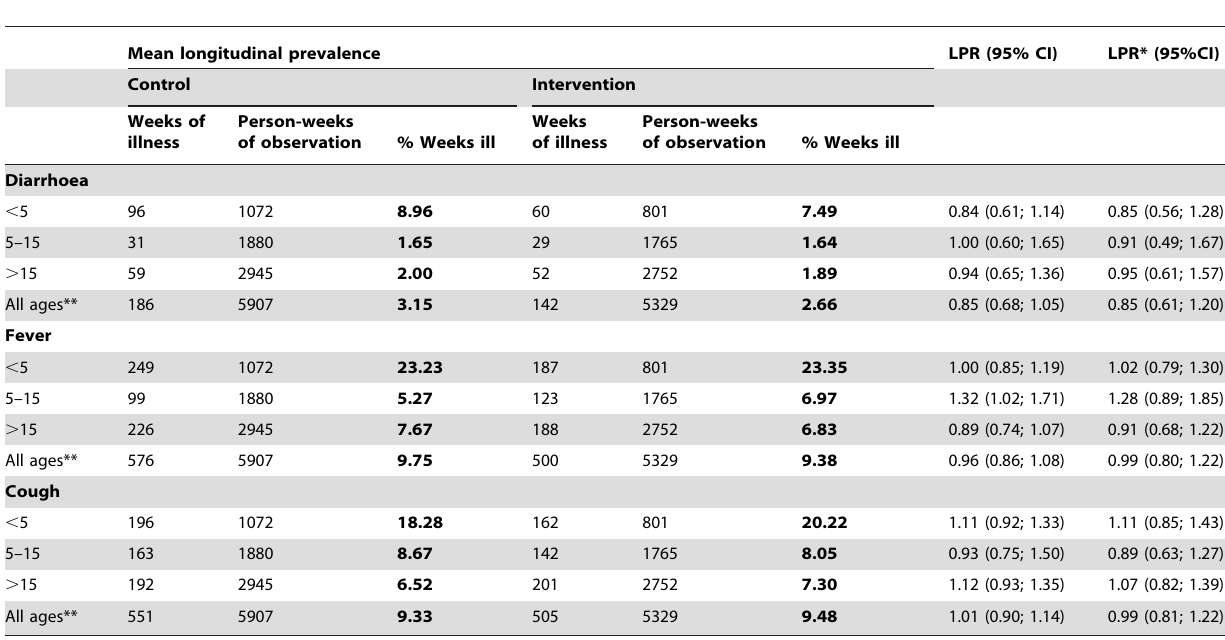
Table 2. Longitudinal prevalence of diarrhoea and other health conditions by age and treatment group.